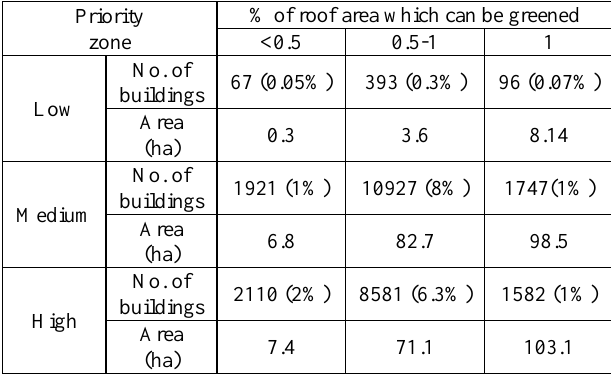
Table 3. Priority-wise percentage of total potential roofs in terms of total area of roofs and number of buildings in each category with respect to percentage of flat roof